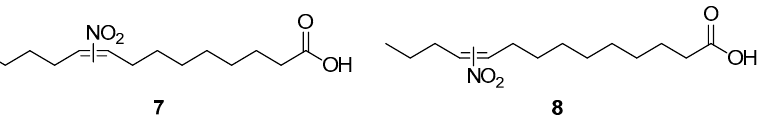
Figure 4. Nitroalkenes showing similar deactivation rate of TNF α -induced NF- κ B signaling pathway with NO 2 -OA.